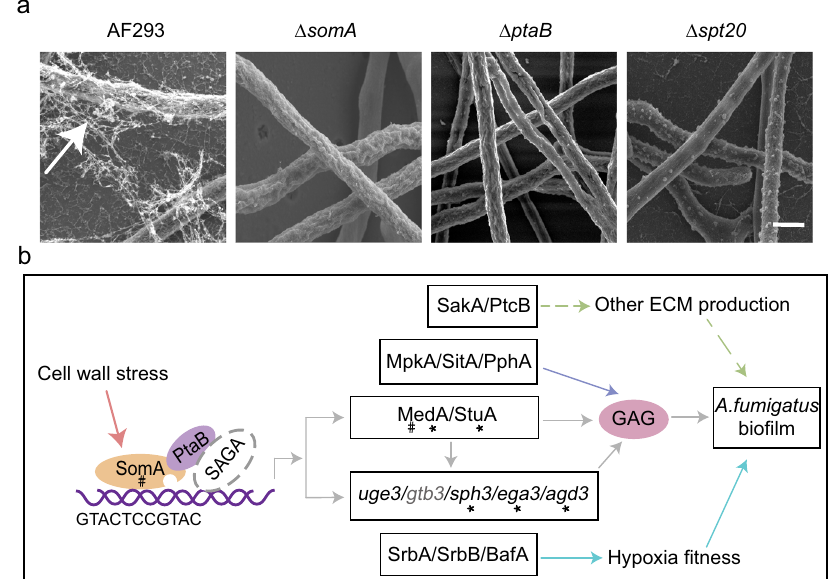
Fig. 2 Morphology and regulatory network of A. fumigatus bio fi lms. a Scanning electron micrographs of the A. fumigatus bio fi lms. Extensive matrix material, indicated by the arrow, is present on bio fi lms of A. fumigatus wild-type AF293, but is absent in the deletion mutants of somA, ptaB and spt20 . Scale bars: 2 μ m. b Regulatory network model of A. fumigatus bio fi lms. The asterisks indicated direct binding by SomA via to a conserved “ GTACTCCGTAC ” motif. The # indicated regulators were also required in the GAG production under cell wall stresses